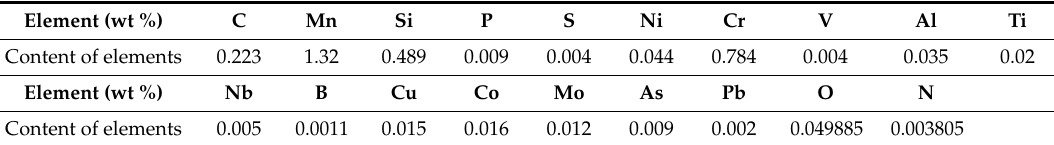
Table 2. Chemical composition of the investigated